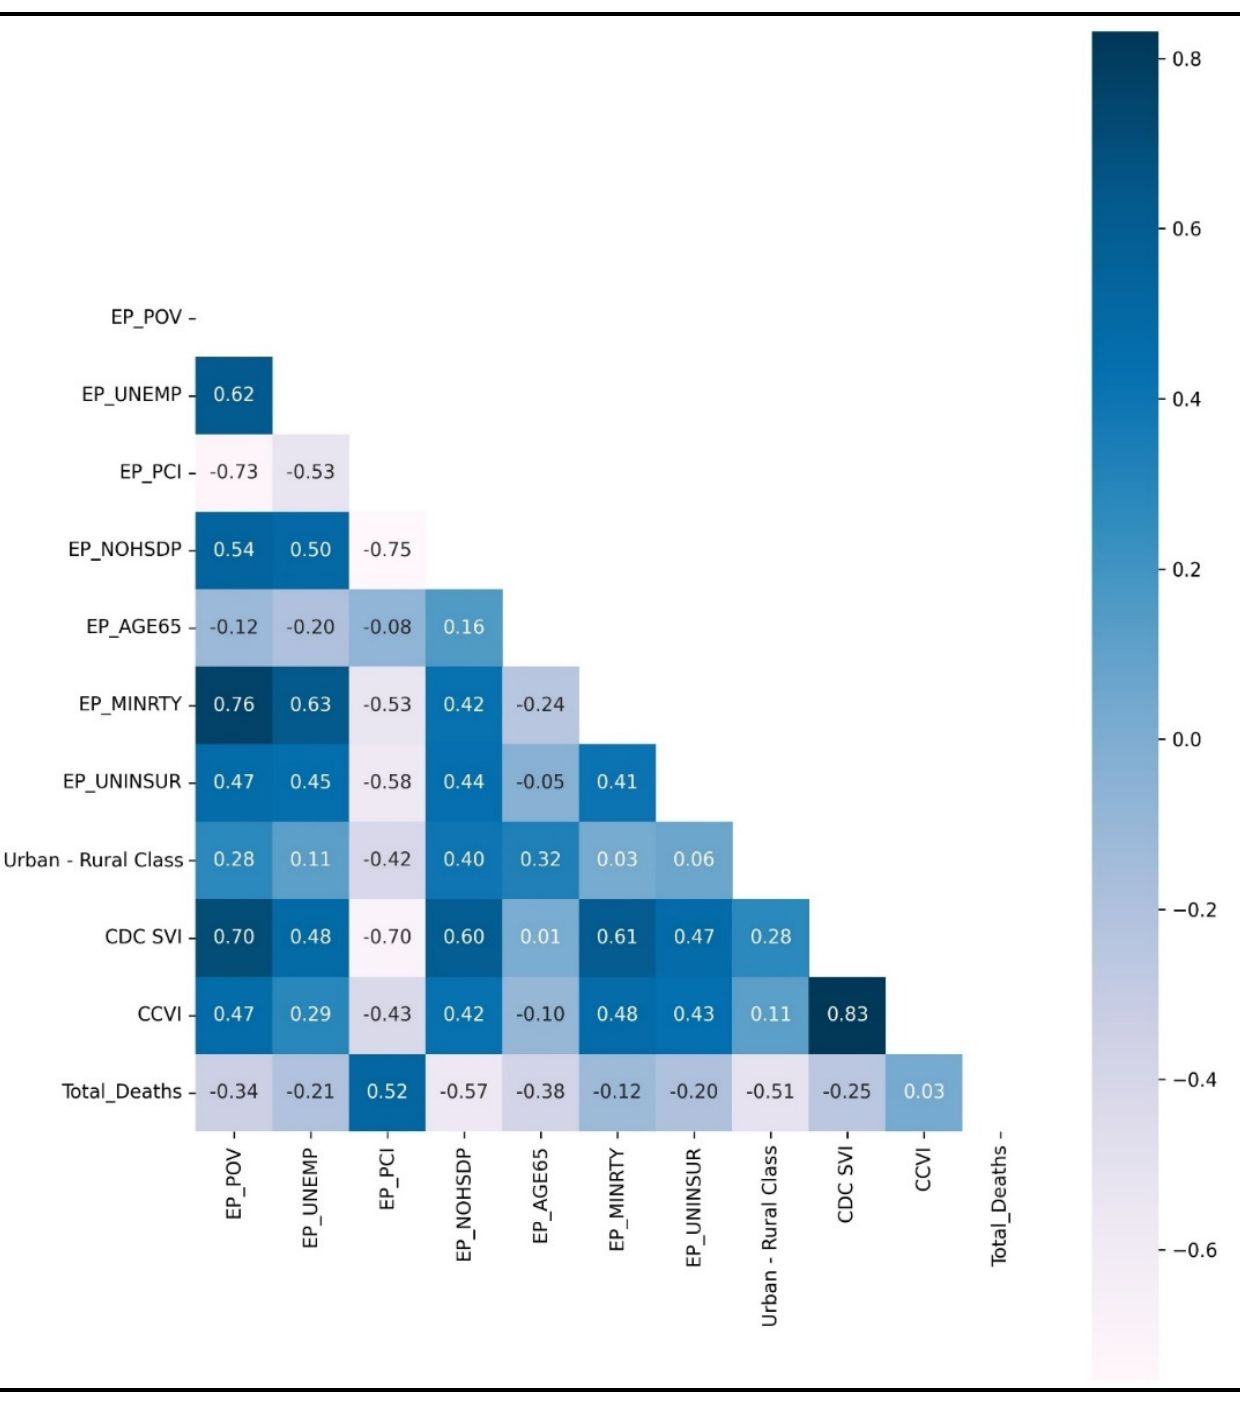
Figure 4. Heat Map Correlation Matrix of County-Level Features for County-Level Total Deaths (Cumulative COVID-19 Deaths).